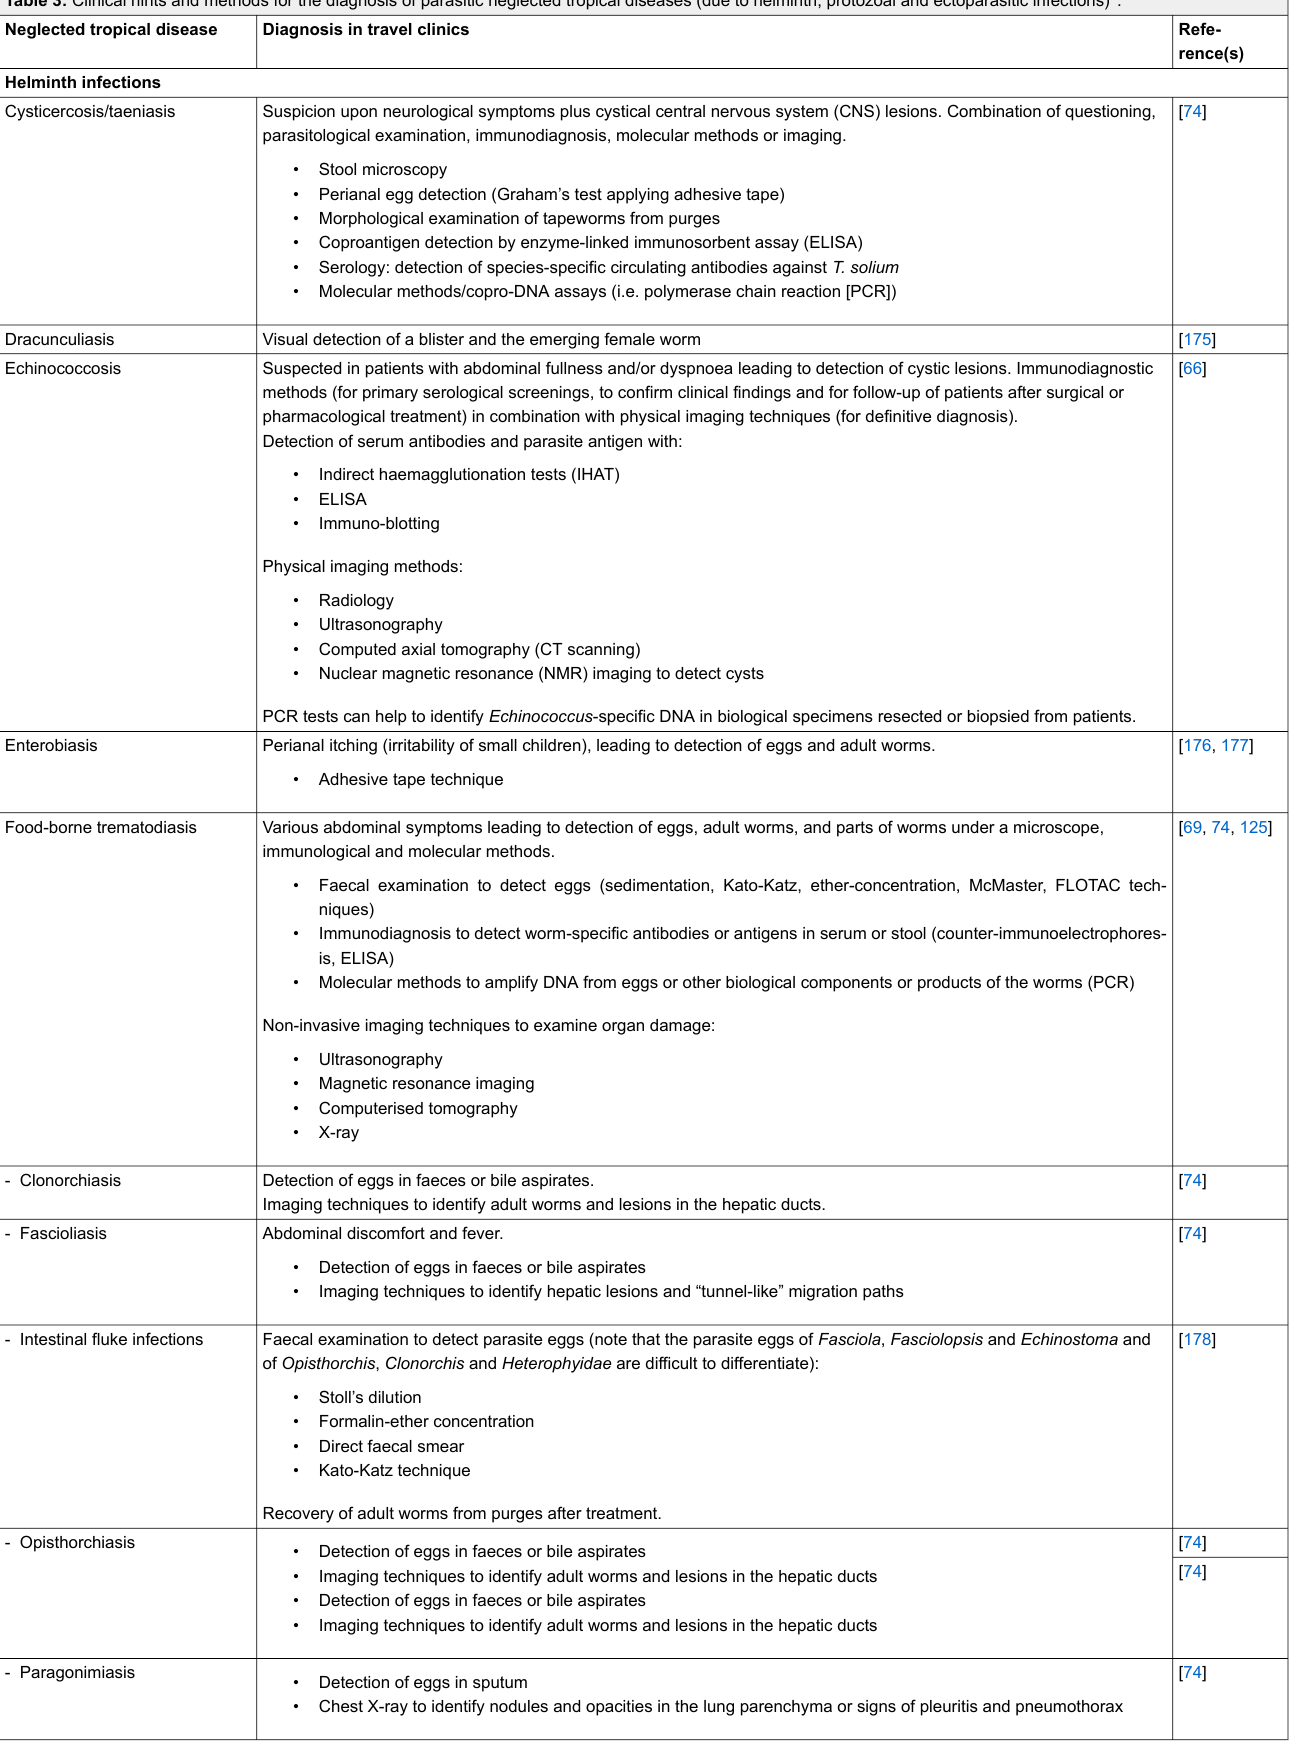
Table 3: Clinical hints and methods for the diagnosis of parasitic neglected tropical diseases (due to helminth, protozoal and ectoparasitic infections) a . Neglected tropical